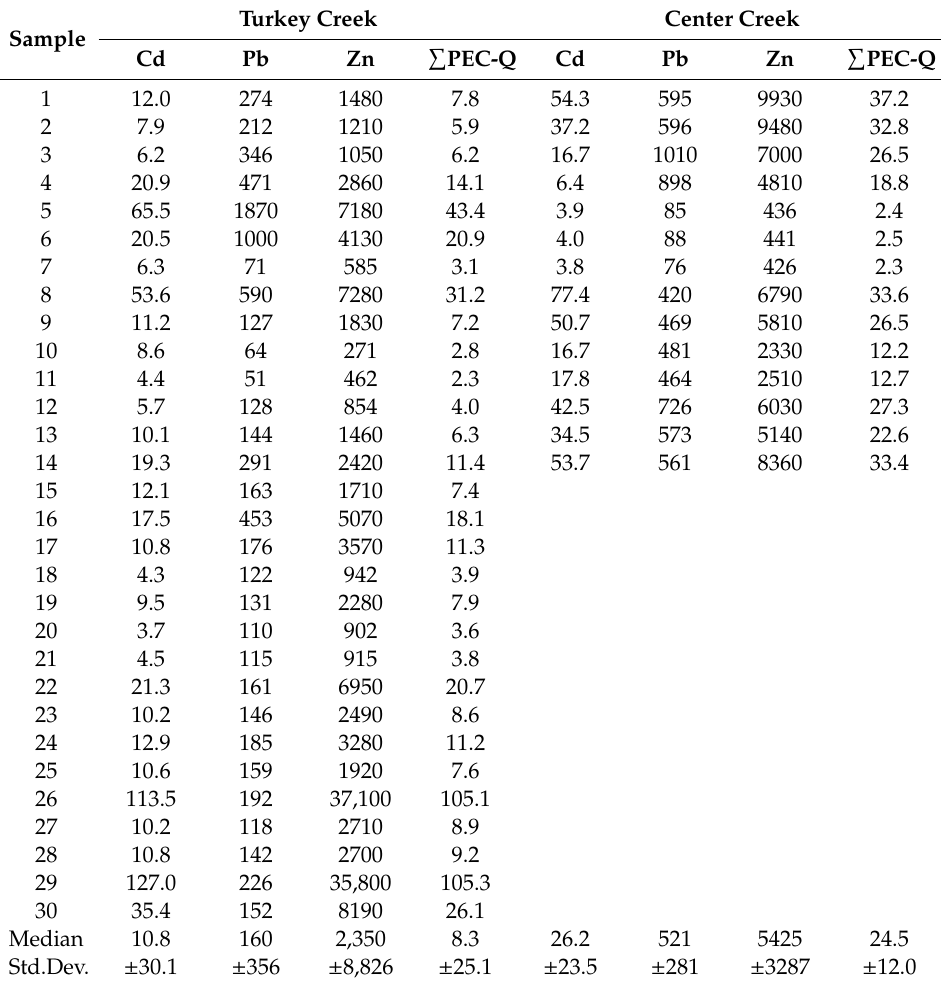
Table 1. Metal concentration in sediments (in mg / kg) from Turkey Creek and Center Creek, Missouri. Samples were collected in 2018–2019, and are listed in downstream order.